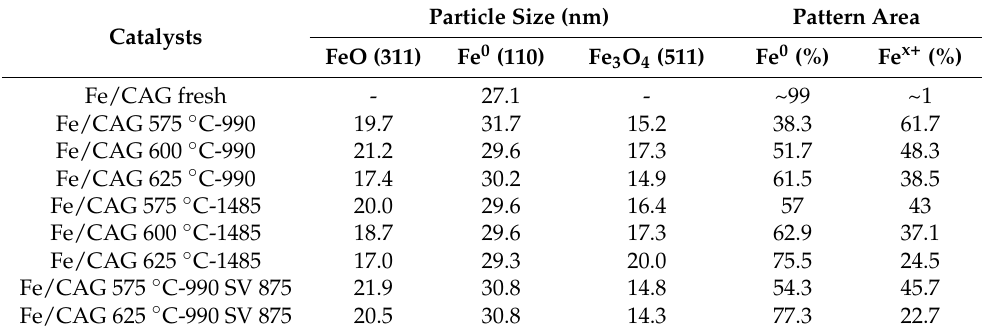
Table A2. Particle size, estimated and by XRD patterns, for three different Fe phases in toluene decomposition spent catalysts.